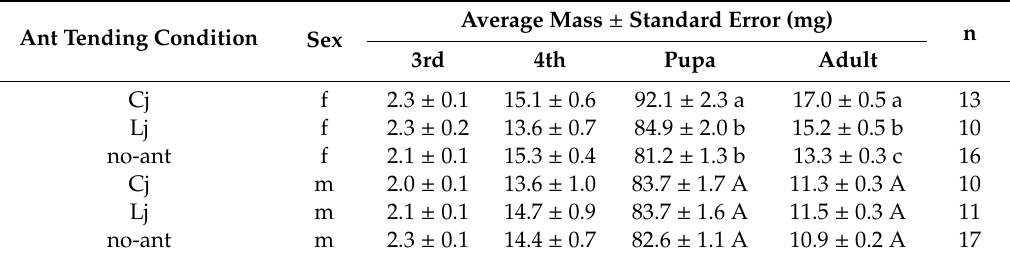
Table 1. Mass of newly shed larvae, pupae, and dried